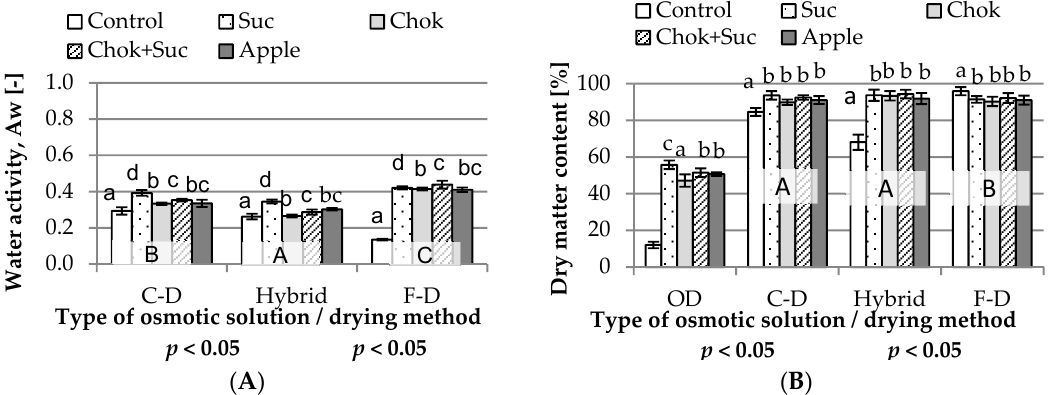
Figure 2. Influence of the type of osmotic solution on: water activity ( A ) and dry matter content ( B ) of osmo-dehydrated (at 50 °C for 24 h) and dried quince slices. Designations: A–C and a–d— homogeneous groups; Suc, Chok, Chok + Suc, apple—coding the type of osmotic solution, as given in the experimental procedure.